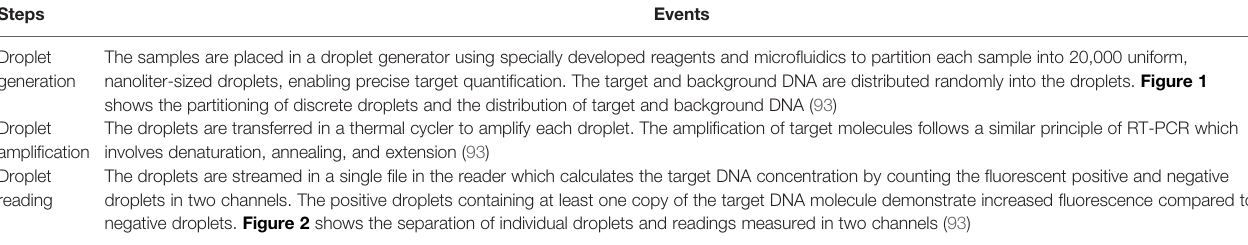
TABLE 10 | Summary of the steps and events in